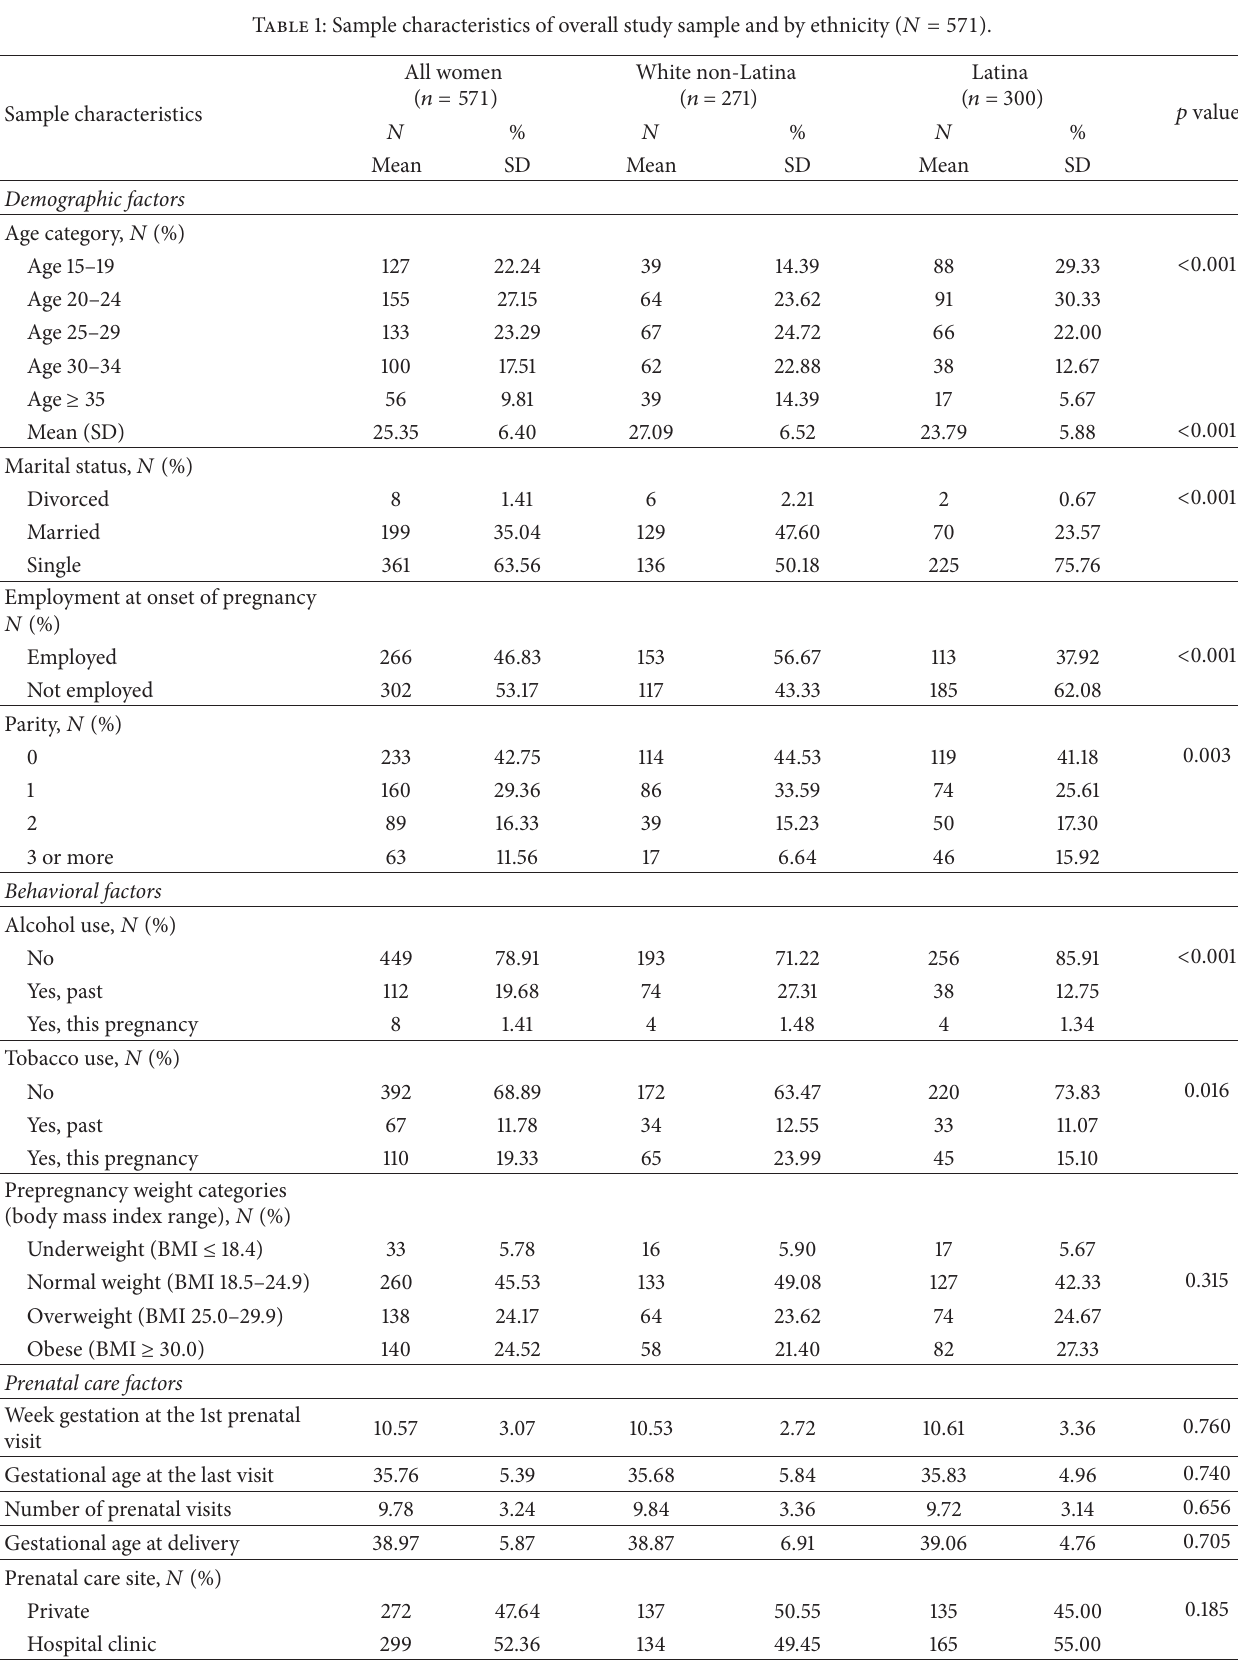
Table 1: Sample characteristics of overall study sample and by ethnicity ( 𝑁 = 571